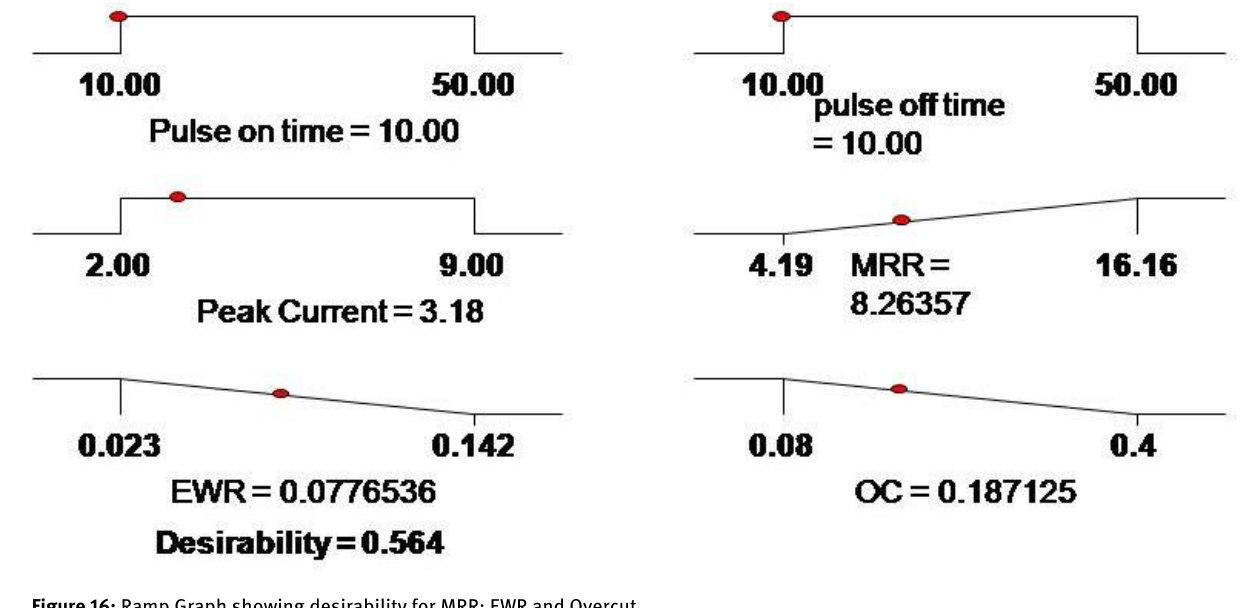
Figure 16: Ramp Graph showing desirability for MRR; EWR and Overcut Table 9: Validation of Mathematical models with experimental data Exp. No.